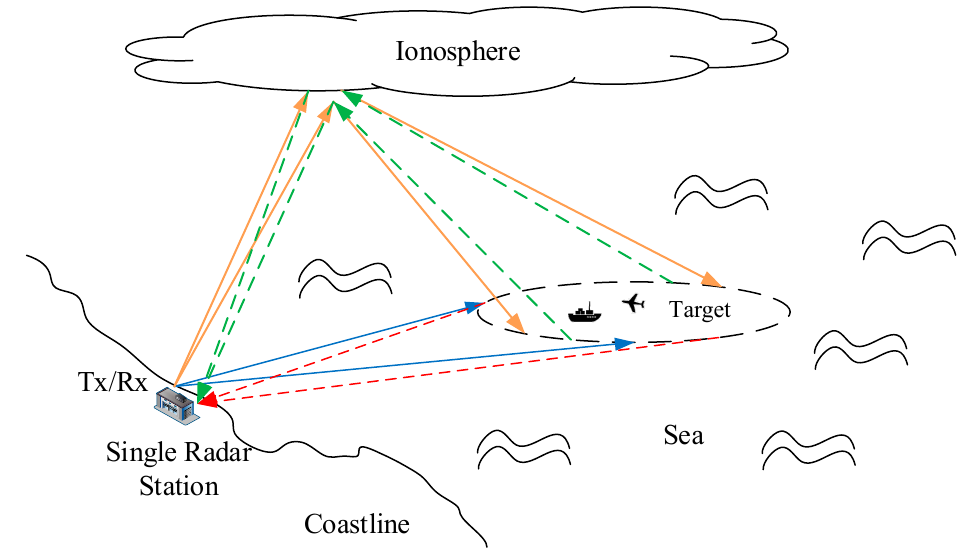
Figure 1. Geometric model of the high-frequency (HF) mixed-mode surface wave radar (MMSWR) system.